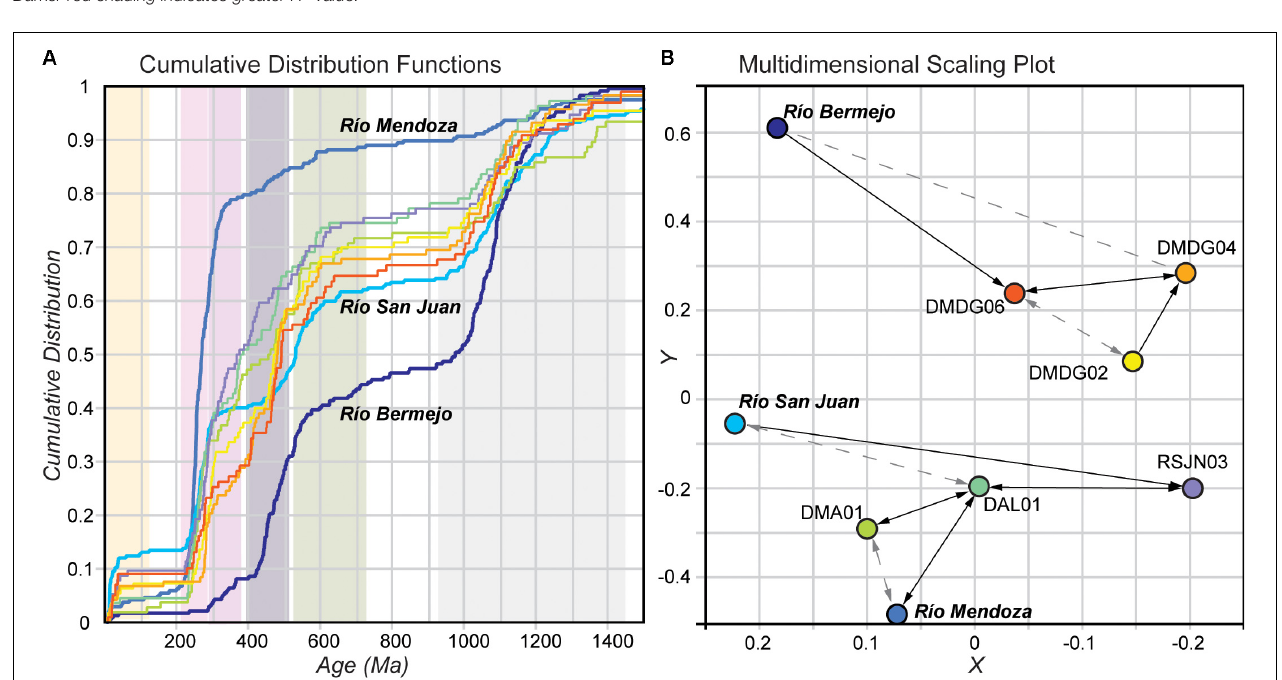
FIGURE 5 | Comparison plots of fluvial sources (blue and labeled) and eolian mixed samples (color coded and labeled). (A) Detrital zircon U-Pb age distribution cumulative density functions (CDF), where line color corresponds to colored circles in B and sample locations in Figure 2B , with emphasis on key age populations (color shading). Notice all samples plot in between fluvial sources Río Mendoza and Río Bermejo in CDF space. (B) Two-dimensional multidimensional scaling (MDS) plot of detrital zircon U-Pb age distributions generated for river sources and mixed eolian samples using R2 cross-correlation coefficient on KDEs. Lines represent nearest neighbor (black lines), second nearest neighbor (gray dashed line), and axis are